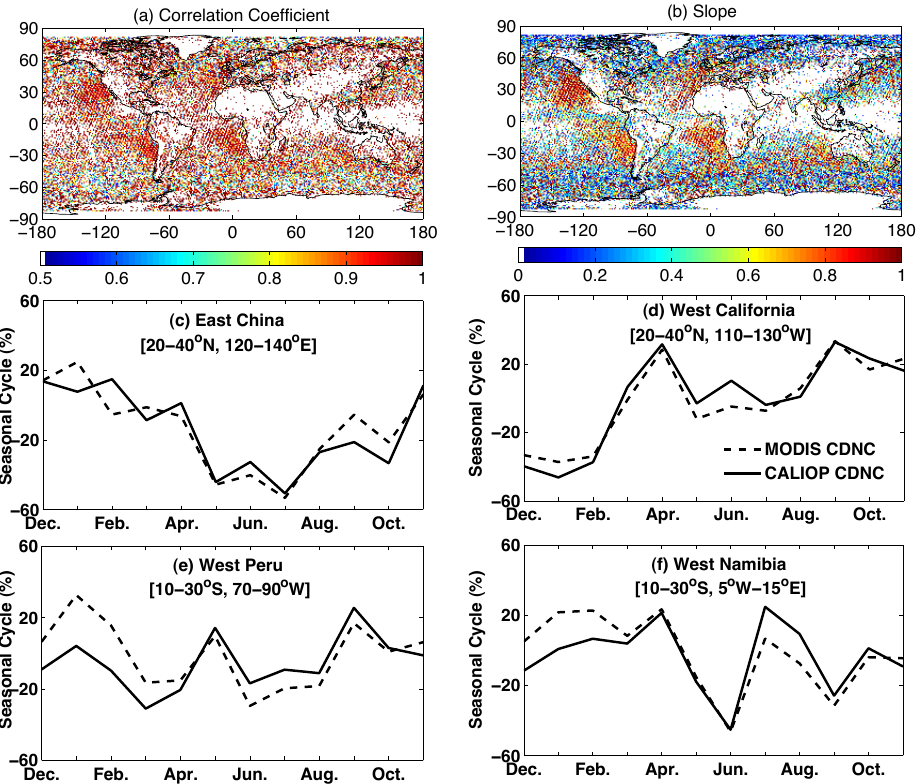
Figure 2. Geographical distributions of the correlation coefficients (a) and the slopes (b) between monthly MODIS and CALIOP CDNCs, and seasonal variations of MODIS (dashed line) and CALIOP (solid line) CDNCs for a year from December 2007 to November 2008 and for four different regions: east of China ( c ; regions of 20–40 ◦ N and 120–140 ◦ E), west of California ( d ; regions of 20–40 ◦ N and 110–130 ◦ E), west of Peru ( e ; regions of 10–30 ◦ S and 70–90 ◦ W) and west of Namibia ( f ; regions of 10–30 ◦ S and 5 ◦ W–15 ◦